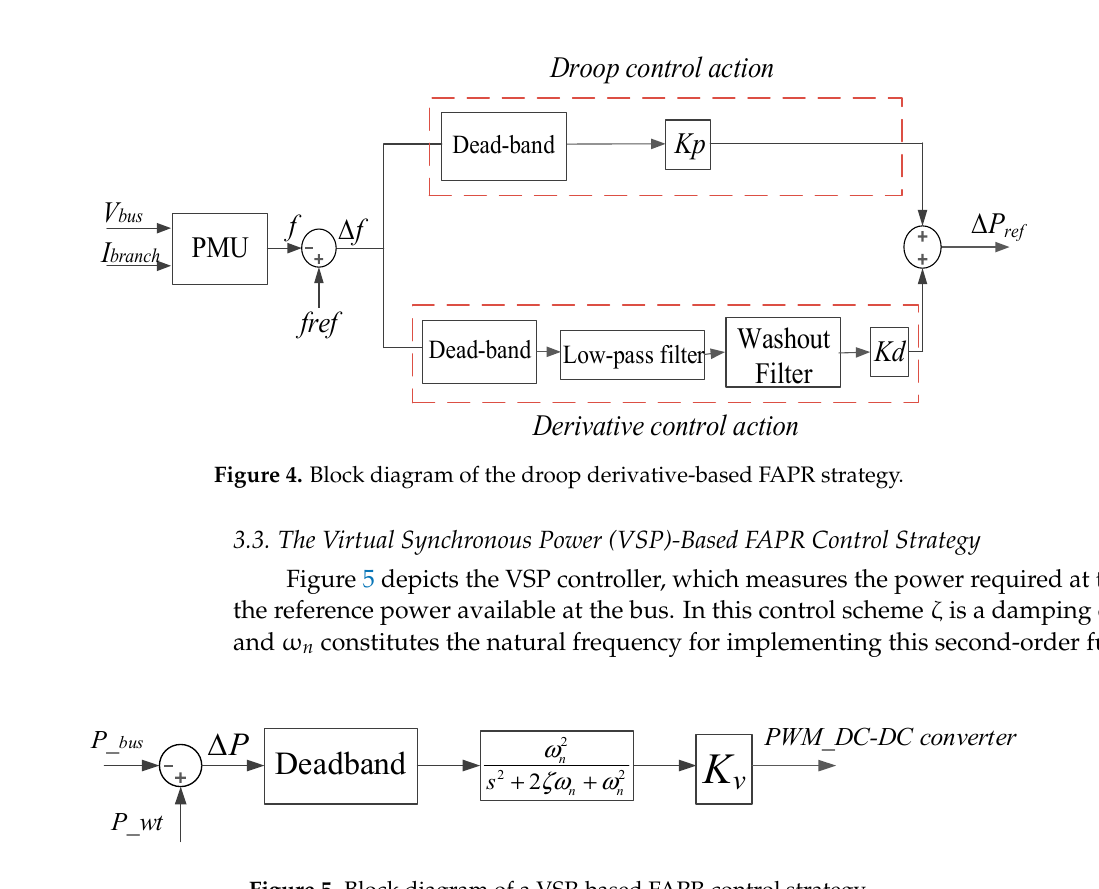
∆ P ref K p Figure 3. The droop-based FAPR controller block diagram. The signal Δ f is amplified by K p . The output signal Δ P ref of FAPR is a supplementary signal attached to the other active power control loop of a grid side converter. Δ P re performs exclusively when an active power imbalance occurs in the system. The drawback of the droop-based FAPR strategy resides in the slow initial response, which could be attributed to low frequency error values. 3.2. The Droop-Derivative Based FAPR Strategy Figure 4 overviews the FAPR based on a droop-derivative hybrid control approach. The setpoint f ref and the signals f and Δ f are obtained as indicated in Section 3.1. Δ f is passed through 2 parallel control loops: The first is a droop controller, which is described in the previous section. The actuation of the droop controller is active for the entire frequency